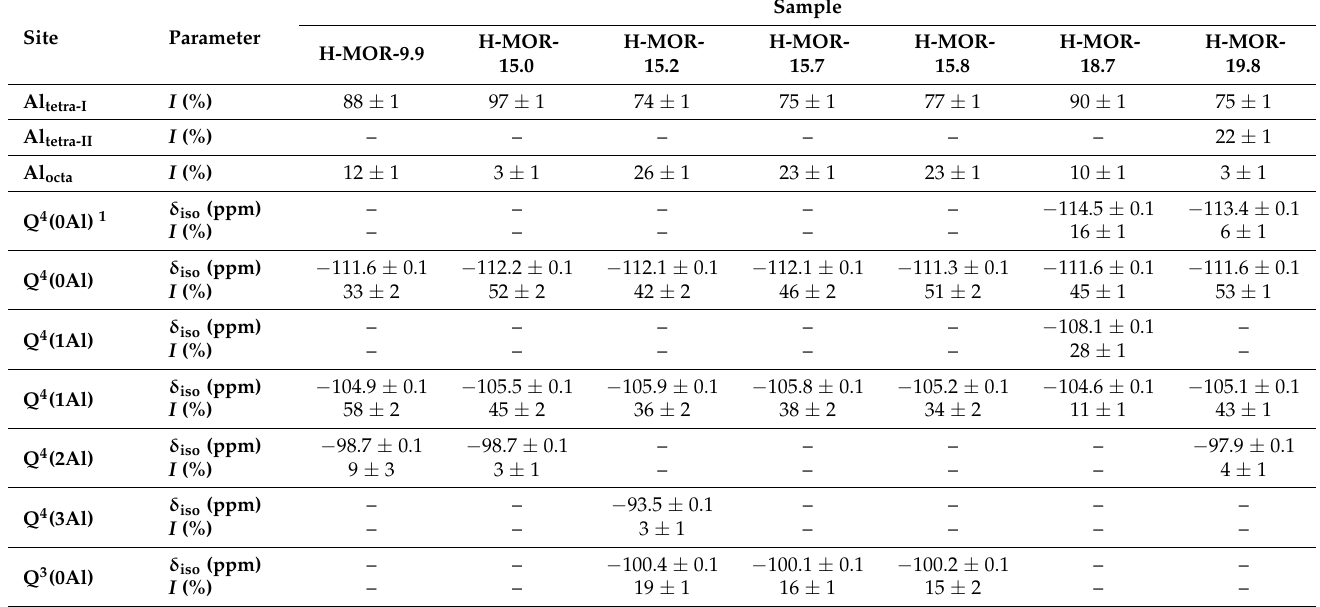
Table 3. Relative integral intestates ( I ) of individual lines 29 Si and 27 Al NMR spectra and 29 Si isotropic chemical shifts ( δ iso ) for the studied H-mordenite